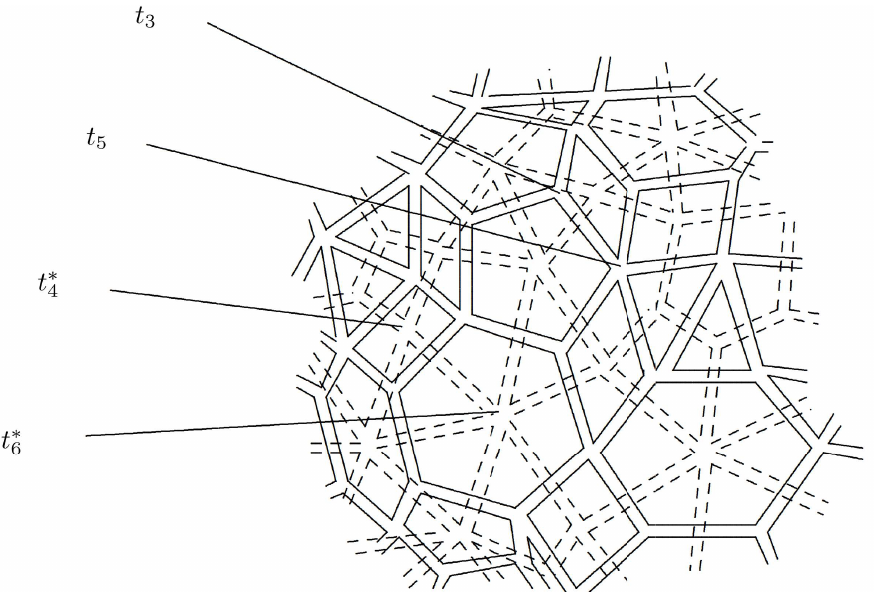
Figure 3 . Dually weighted graph (figure from [27]). We show the propagators as double lines. The couplings t appear at n -vertices, while t ∗ correspond to n -faces of the graph, corresponding to the n n faces of the dual graph depicted by dotted